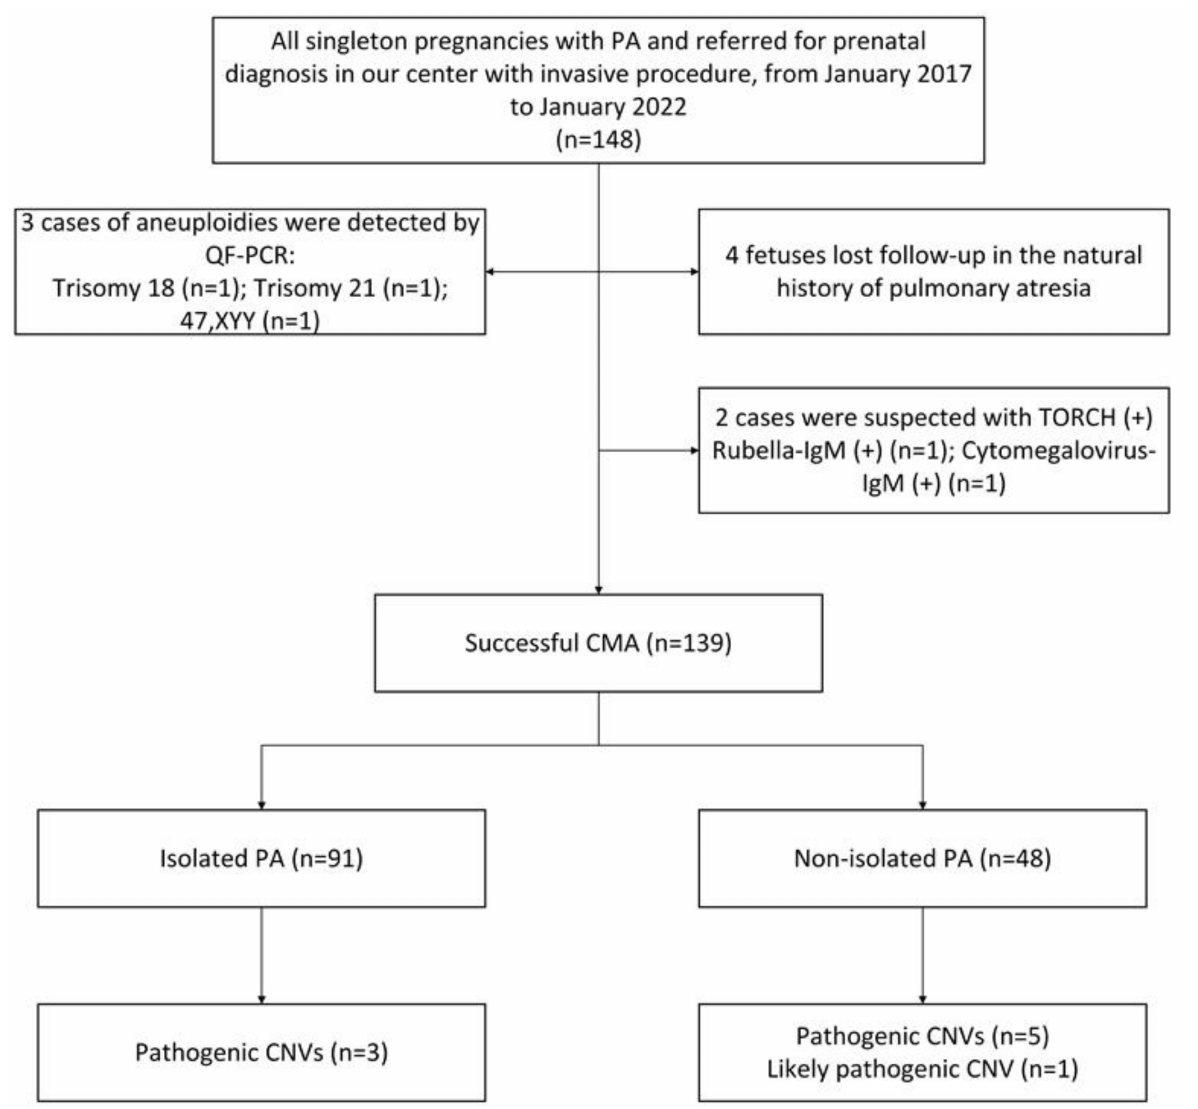
Figure 1. Flow chart of the study